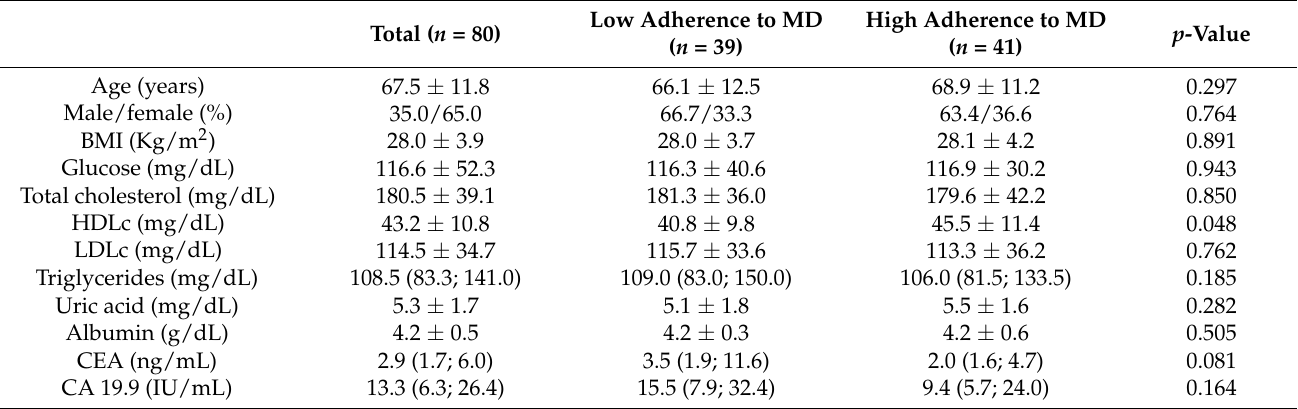
Table 1. Demographic, anthropometric, and biochemical variables of patients with colorectal cancer according to their adherence to the Mediterranean